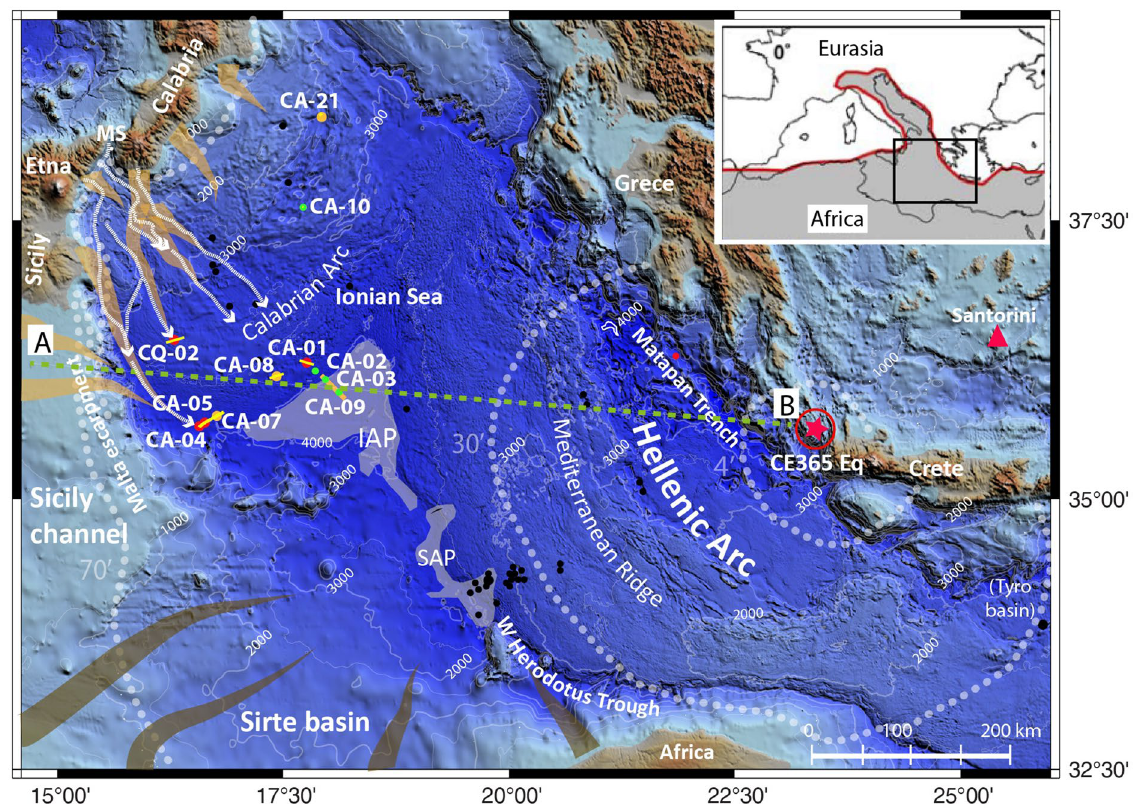
Figure 1. a: bathymetric map of the Ionian Sea with location of sediment cores CALA-01, CALA-04, CALA- 05 and CQ14_02 (red dots) described in this study. Core CALA-05 was analysed in a previous study to define composition and structure of the HAT deposit 3 . Green dots represent cores described only in Fig. 7 in the correlation log. Yellow dots represent cores described in the Supplementary material (cores CALA-07, CALA- 08, CALA-21: SM2-SM4). Black dots represent HAT occurrence in other cores 21 . Orange and brown lines: HAT sediment source areas 3,31 . A-B dotted green line: cross section in the conceptual model of Fig. 10. Yellow lines along the core transects: Chirp profiles in Fig. 2. Orange thick line across cores CA-03 and CA-09: Chirp profile in Fig. 11. White lines represent major canyon systems from the Messina Strait (MS) region down to the abyssal plain. Dotted grey lines show tsunami wave front at 4, 30, and 70 min after the earthquake 6 . Red star: epicentral area of the CE 365 earthquake. Name of cores is abbreviated. CA: CALA; CQ:CQ14. Inset map: the black rectangle represents the study region in the frame of the Africa (grey pattern)/Eurasia plate boundary (in red) in the Mediterranean region. Morphobathymetric data are from Global Bathymetry and Elevation Digital Elevation Model: SRTM30_PLUS v8 (https:// data. gov. au/ data/ datas et/ global- hills hading- from- srtm30_ plus- v8-0- nerp- te- 13–1- eatlas- source- ucsd/). The map was compiled using GMT package (version 6.0.0; ic-mappi ng-tools .org/), and the image was edited using Adobe Illustrator (CS6; https:// www. adobe.